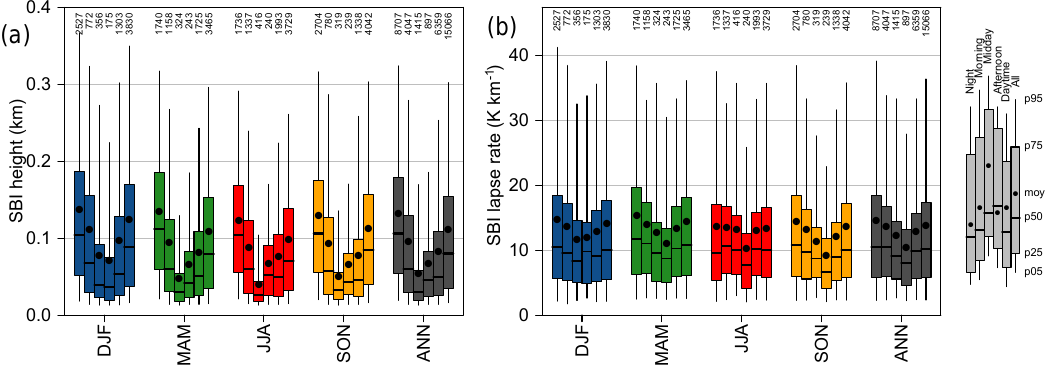
Figure 4. SBI height ( a ) and temperature lapse rate between the surface and the top of the SBI ( b ). Results are shown for each season (one colour per season) and for the different time slots (adjacent bars from left to right: night, morning, midday, afternoon, daytime, entire day; the legend is indicated in grey on the right side). The number of profiles for each bar is indicated on the